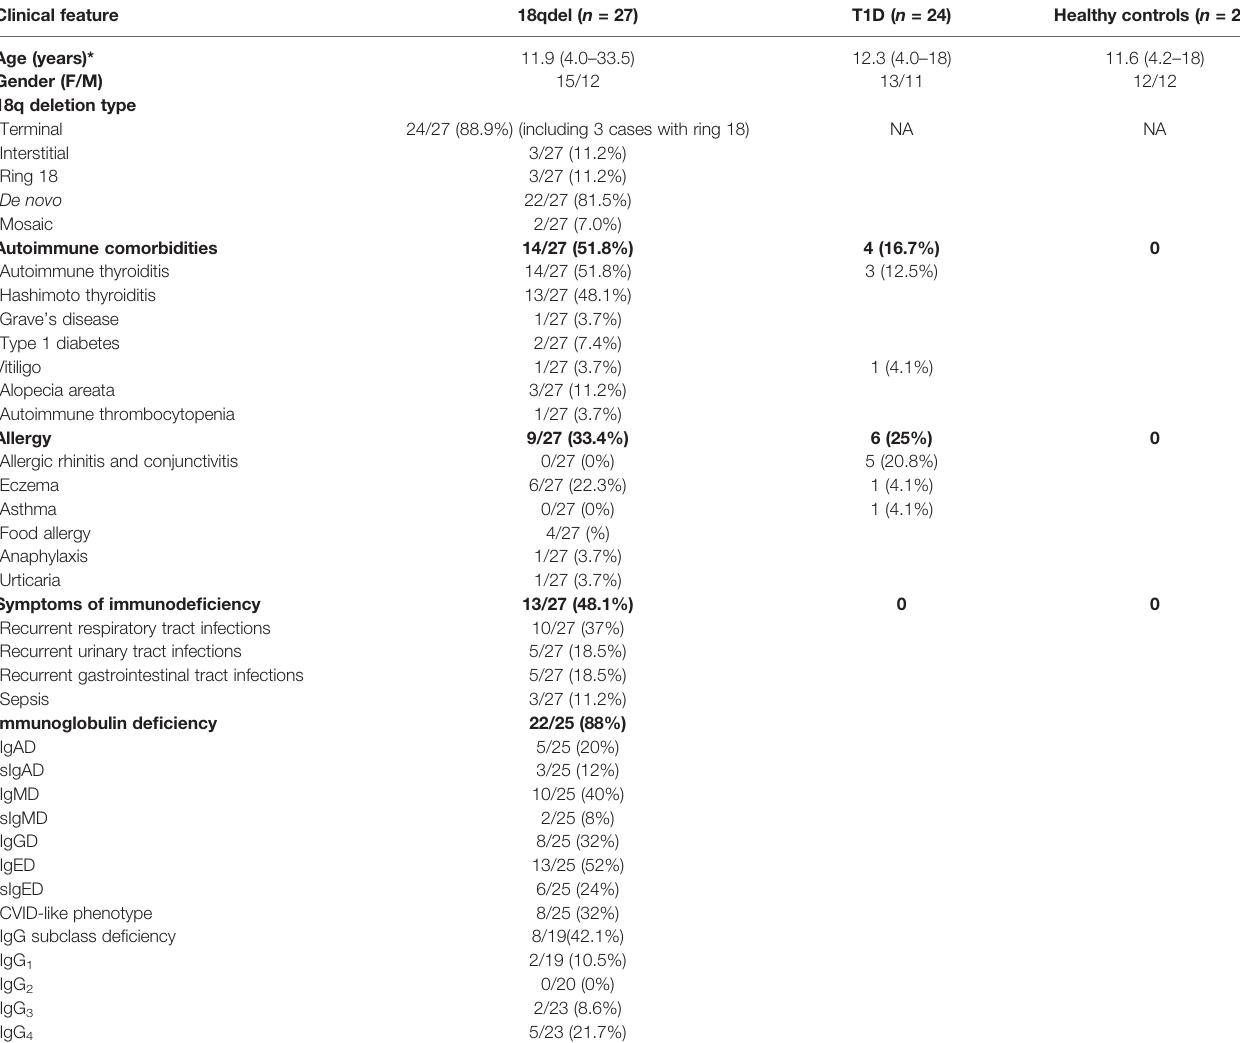
TABLE 2 | Clinical characteristics of patients with 18q del syndrome. Clinical